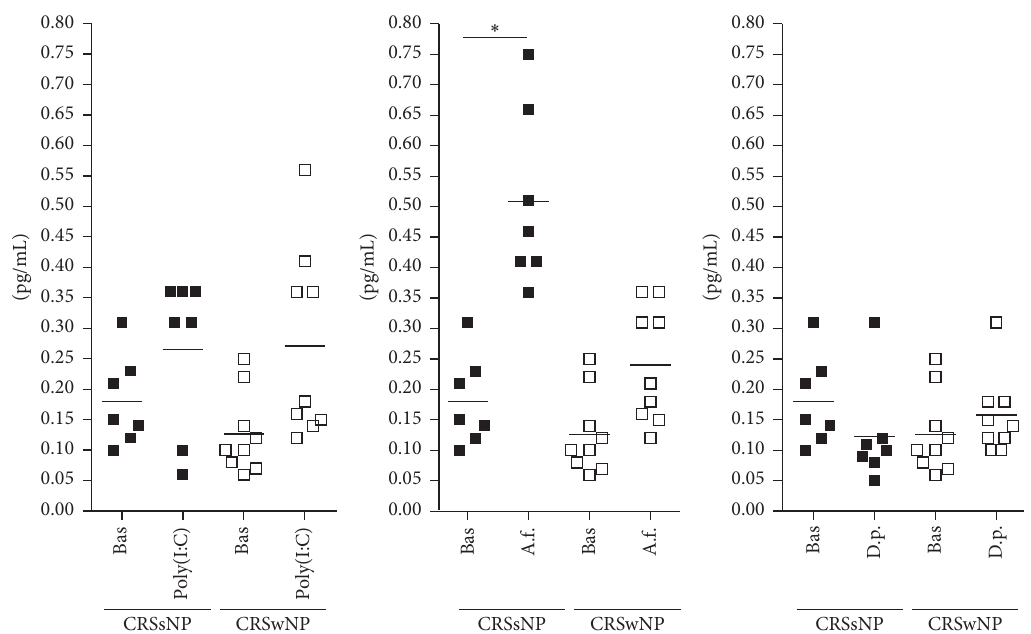
Figure1:MeanandsinglevaluesofIL-25releaseinCRSsNPandCRSwNPpatients.Bas=Baseline;A.f.= A . fumigatus ;D.p.= D . pteronyssinus . ∗ 𝑝 < 0.001 .